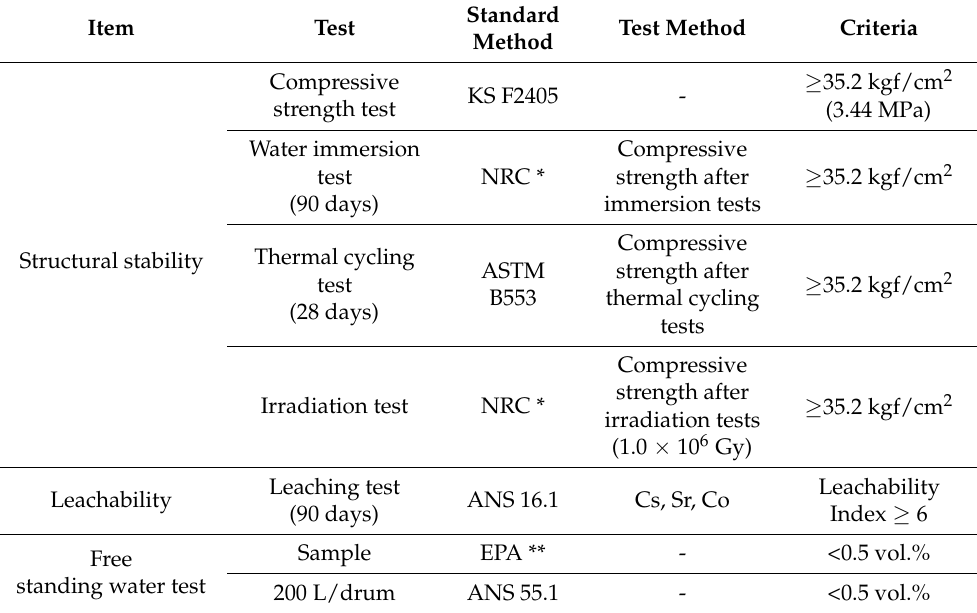
Table 9. Test items and methods specified in KORAD’s acquisition criteria